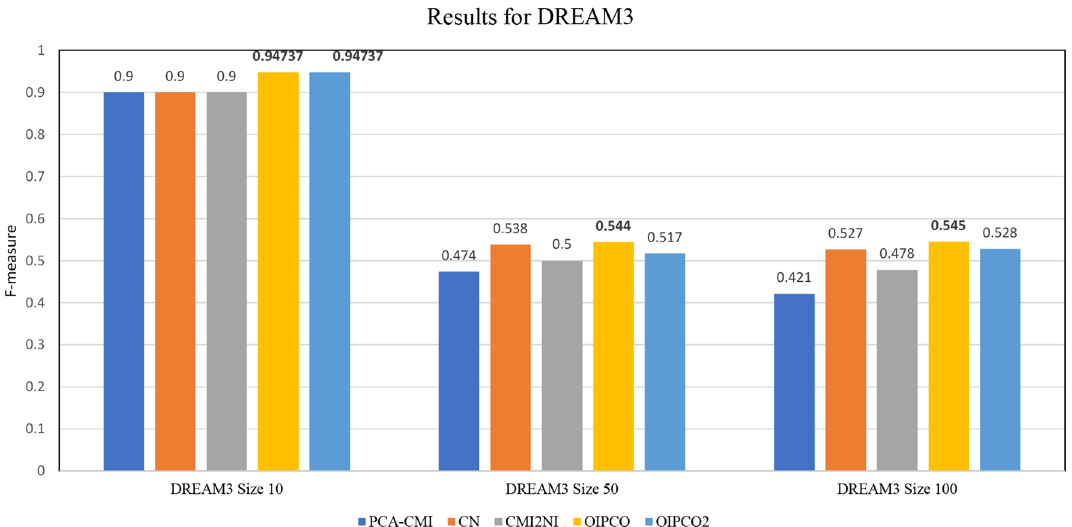
Figure 1. Comparison of F-measure values of OIPCQ and OIPCQ2 algorithms with other methods for learning DREAM3 Challenge with 10 genes, DREAM3 Challenge with 50 gene and DREAM3 Challenge with 100 genes.